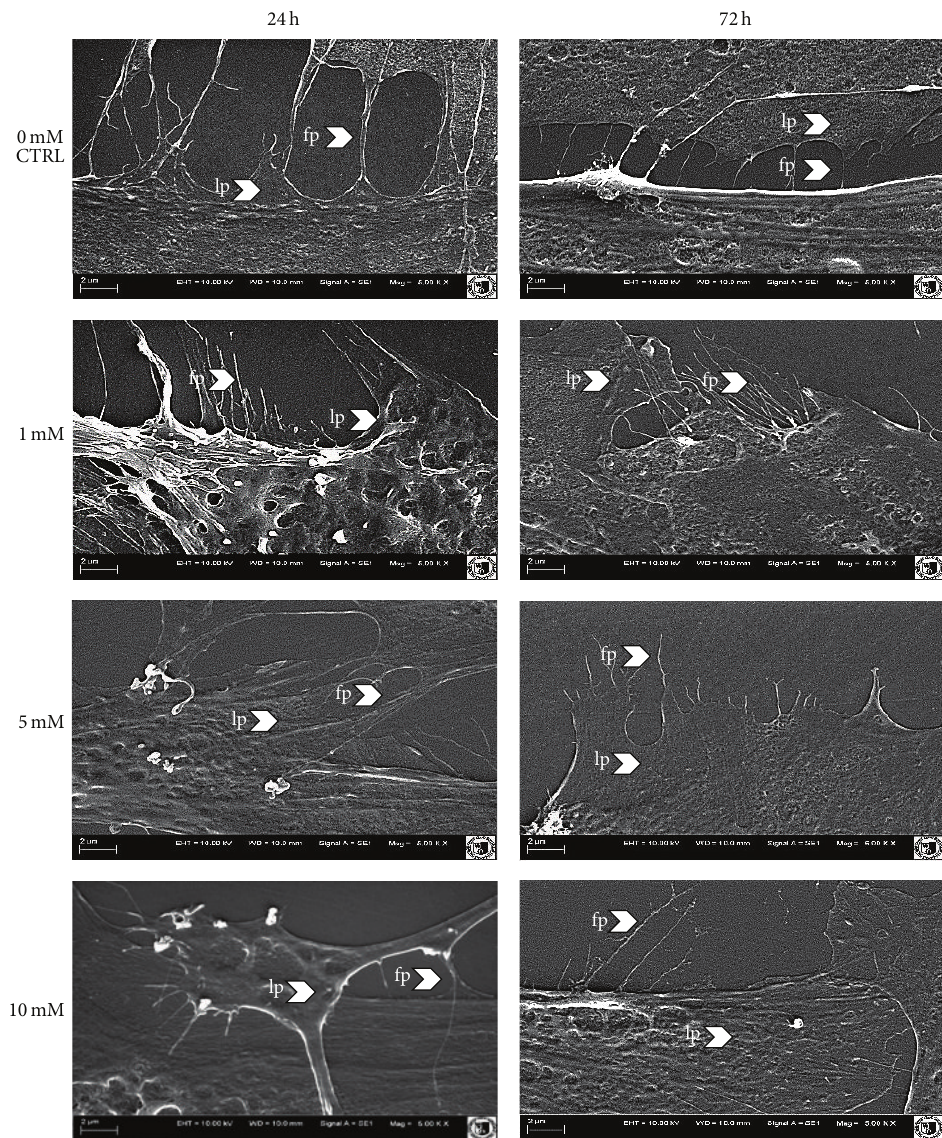
Figure 6: Analysis of cell surface morphology derived from experimental and control culture after 24 h and 72 h of propagation. Cellular projections were indicated with arrows (LP: lamellipodia and FP: filopodia). Depicted images are representative and were obtained from cultures carried out in